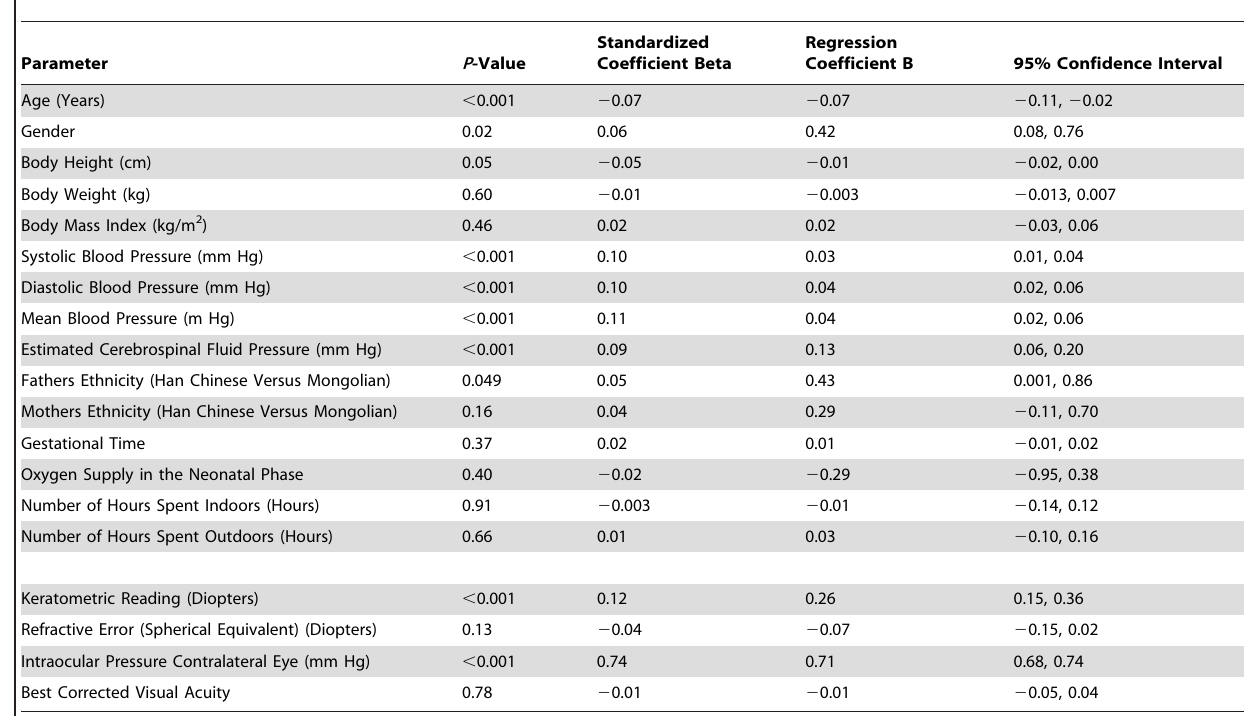
Table 2 . Associations (Univariate Analysis) between Intraocular Pressure (Right Eyes) and Systemic and Ocular Parameters in the Gobi Desert Children Eye Study.